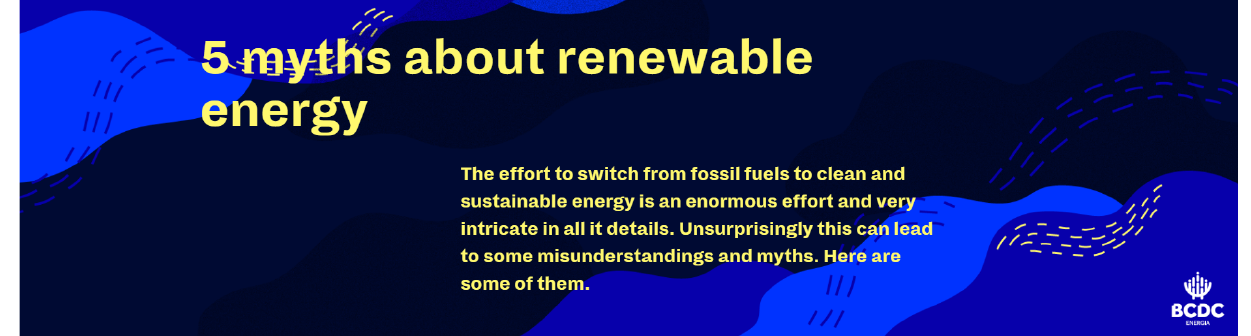
Figure 2. Anchoring with popular concepts. Source: Skolar.fi. (2017). However, their meaning must be self-contained or